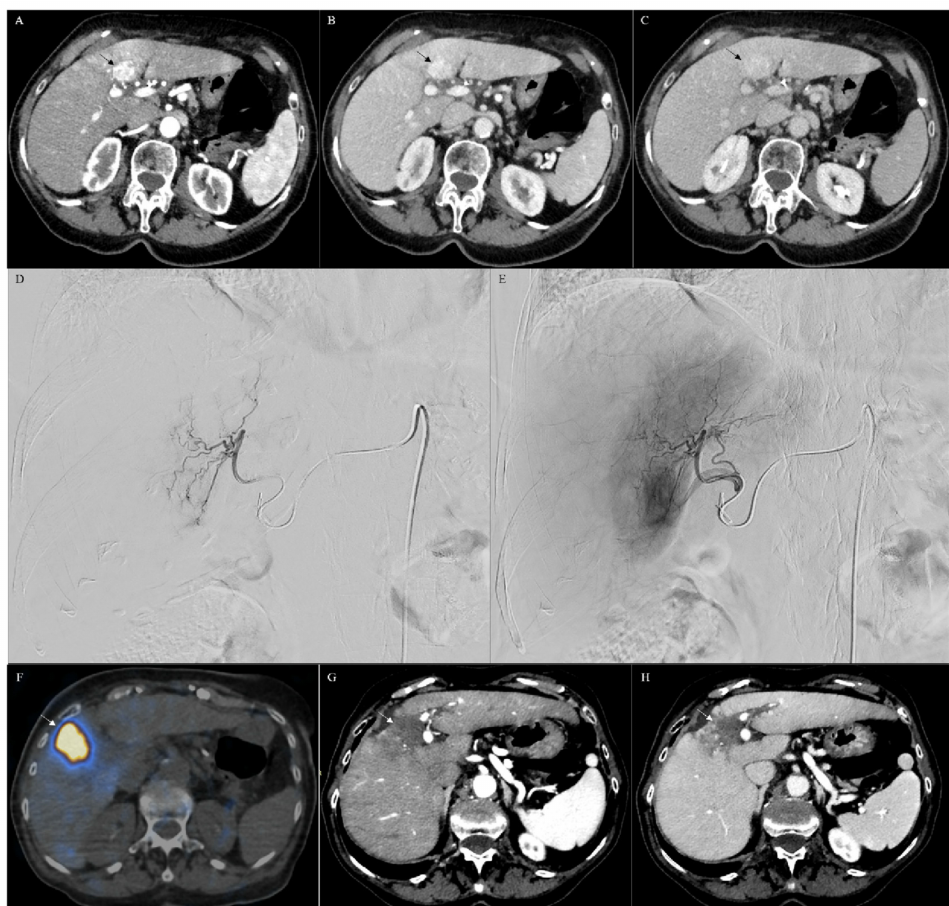
Figure 5. CT of a combined hepatocellular cholangiocarcinoma (arrow) ( A – C ). In particular, CT showed a lesion in the segment IV of the liver with a strong hyperenhancement during the arterial phase ( A ), followed by a persistent enhancement during the portal ( B ) and delayed phases ( C ), consistent with the imaging diagnosis of combined hepatocellular cholan- giocarcinoma, thereafter confirmed with biopsy. The lesion was treated by using transarterial radioembolization (TARE). In particular, during the angiographic study ( D , E ), the artery feeding the liver segment IV was selectively catheterized ( D ), the lesion was confirmed with selective angiography ( E ), and the intra-arterial treatment was selectively performed. Positron emission/computerized tomography (PET/CT ( F )) demonstrated that the treatment was correctly performed, covering all the lesion (arrow in ( F )). CT scan, performed 6 months after TARE, demonstrated complete response of the lesion characterized by no vascularized area in the IV segment of the liver in the arterial (arrow in ( G )) and in the venosus (arrow in ( H ))